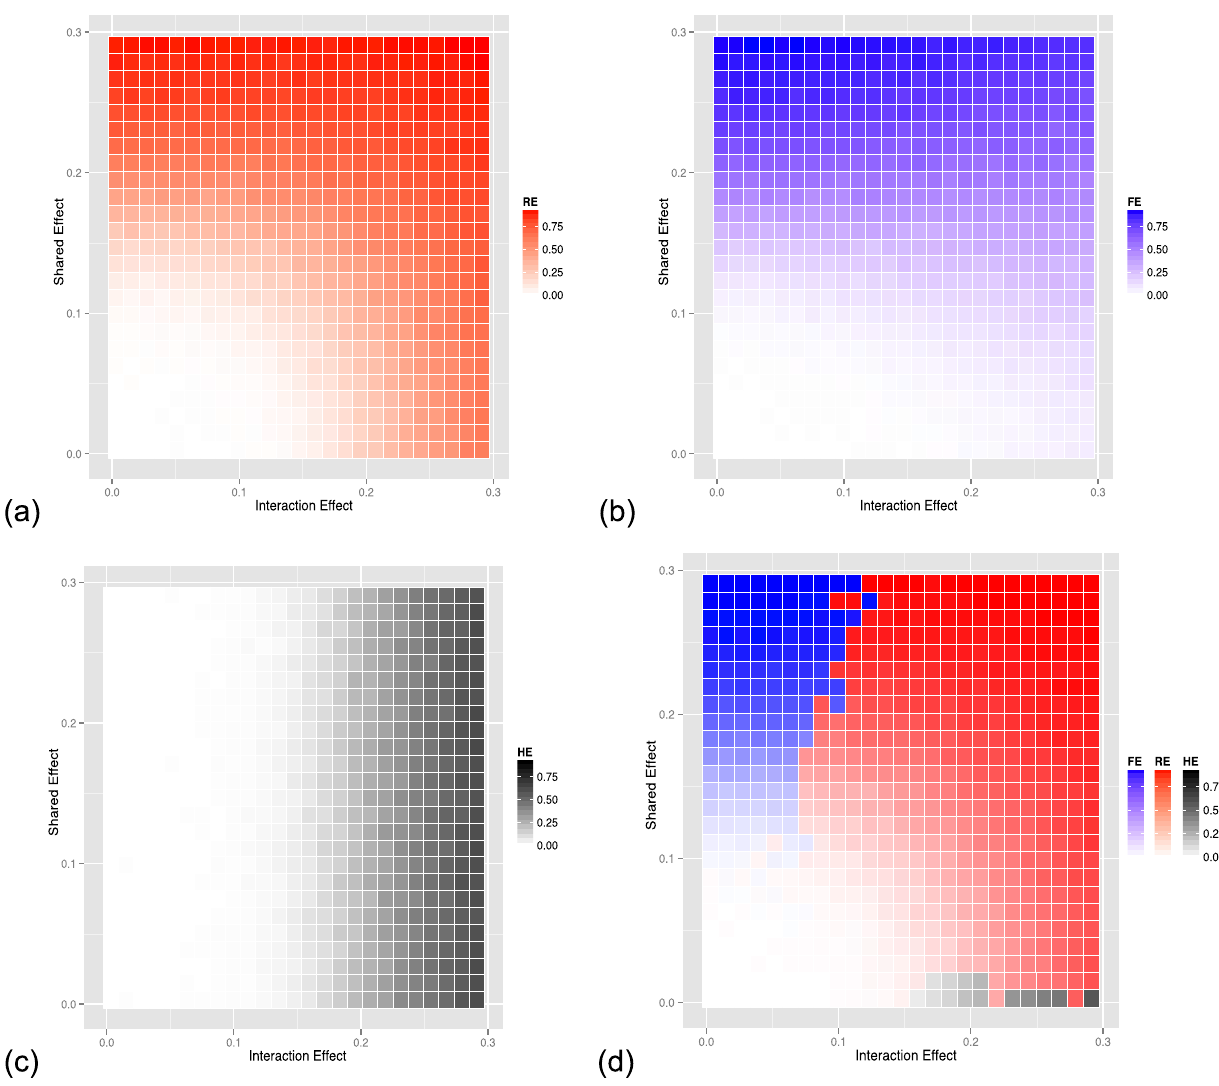
Figure 4. Power of (a) random-effect, (b) fixed-effect meta-analysis and (c) heterogeneity meta-analysis methods as a function of the effect size and the strength of the interaction effect (heterogeneity). (d) shows a comparison of the three methods with the color corresponding to the method with the highest power.